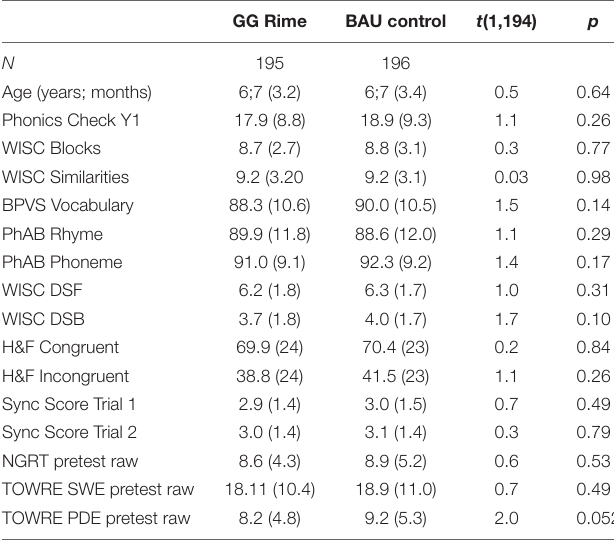
TABLE 1 | Group characteristics expressed as mean and (S.D.) for GG Rime children and the “Business As Usual” control group. GG